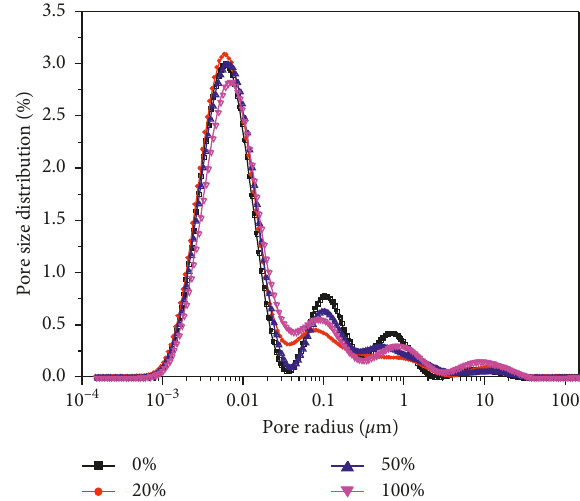
Figure 6: Relationship between pore ratio and aeolian sand content.